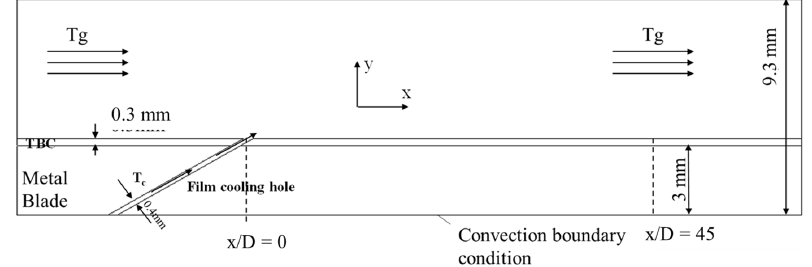
Figure 2. Computation